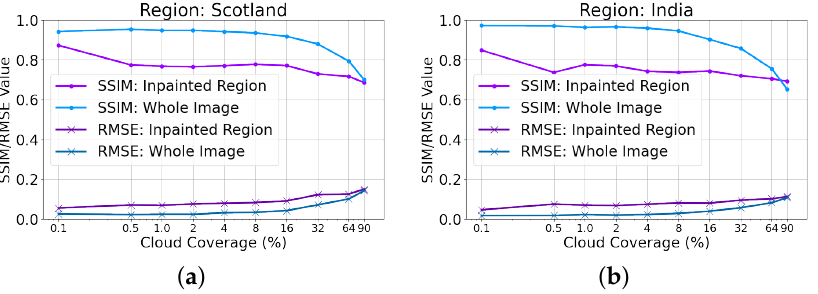
Figure 5. SSIM and RMSE plots for the cloud coverage sweeps for MS-MT mode for ( a ) Scotland Region ( b ) India